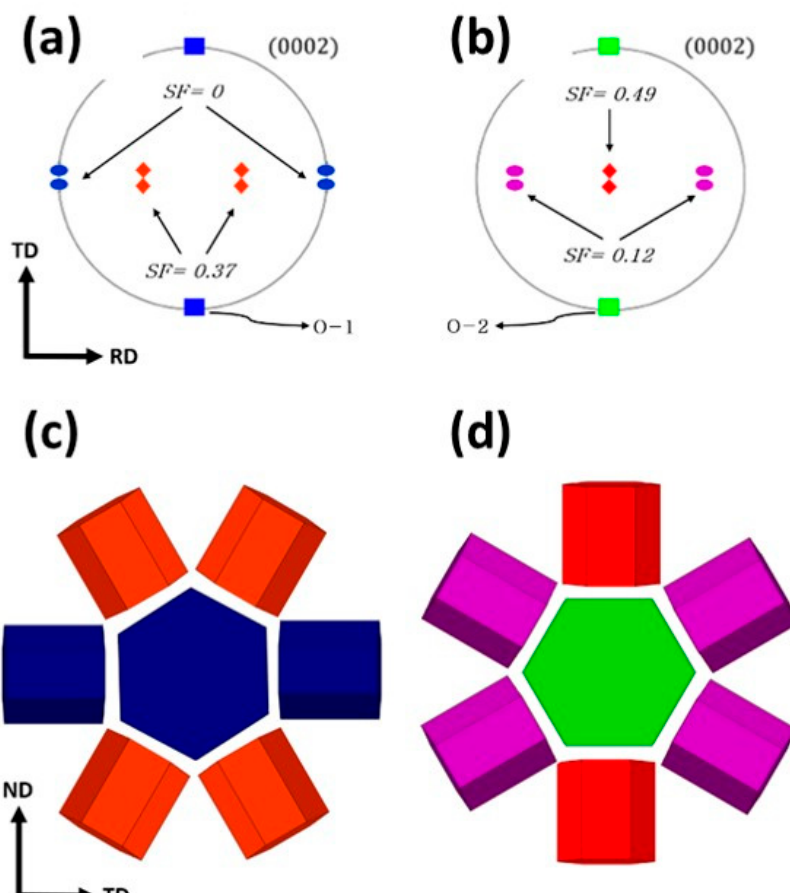
Figure 11. (0002) calculated PF showing the initial orientations ( a ) O-1 and ( b ) O-2, as well as their corresponding extension twin variants. Schematic representation of twin variants for ( c ) O-1 and ( d ) O-2.